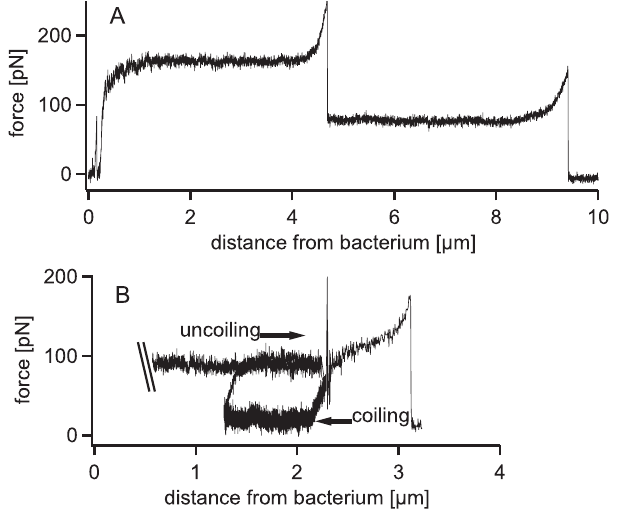
Figure 2. Force/Extension Curves of Fimbriae (A) Force/extension curve when two fimbriae attach to a mannose- coated tip retracting at 2 l m/s. After the first fimbria snaps off the tip, the second fimbria continues to be attached and is pulled until it detaches. The pulling force in the first constant-force region is close to twice that in the second constant-force region, and two distinct break events are observed, indicating that individual fimbriae are being probed. (B) Reversible uncoiling and coiling of a single fimbria. After pulling a fimbria for a set distance, the pulling direction was reversed and the fimbria was observed to coil back at a nonzero force. After a second reversal to the initial pulling velocity, the force returned to its original level. These data show that both uncoiling and coiling are sequential and reversible. The spring constant of the cantilever used in these pulls was 7.9 pN/nm, and the pulls were done on two different bacteria. Most of the . 5,000 successful constant velocity pulls we observed are qualitatively similar to those in Figures 1B or 2A with two (shown here) or more fimbriae. The main difference was in the length of the constant- force region as expected from the variability of the length of fimbriae. DOI: 10.1371/journal.pbio.0040298.g002